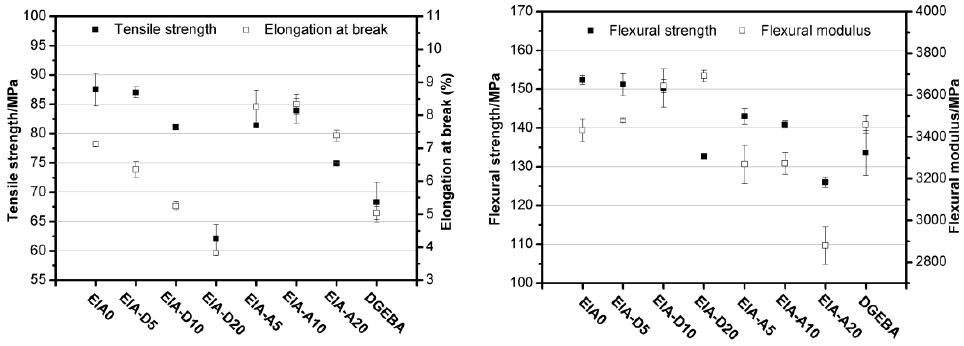
Figure 4. Mechanical properties of the cured EP resins. EIA0 and DGEBA refer to the cured samples without comonomers; D and A denote the DVB (divinyl benzene) and AESO (acrylated epoxidized soybean oil) co-monomers, respectively.